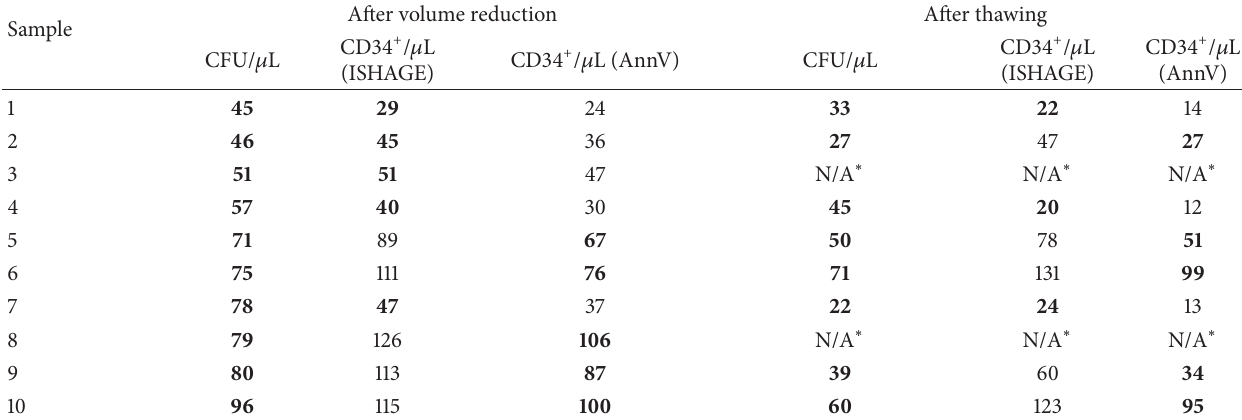
Table 1: Ratio of CFU and CD34 + -cells prior to and after thawing assessed by different methods. Sample